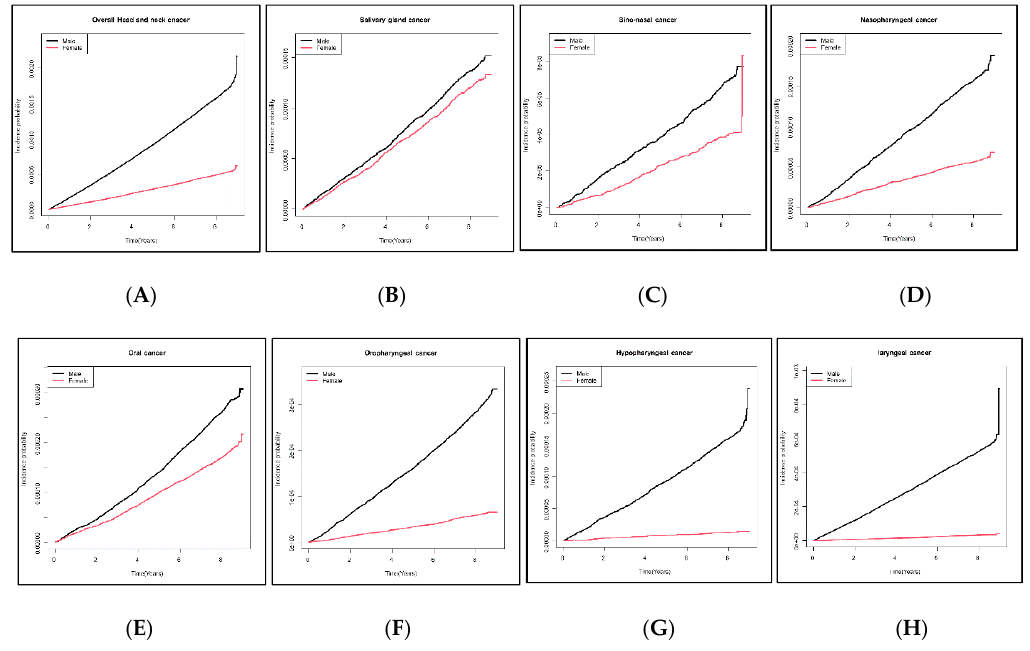
Figure 2. Kaplan–Meier curve of the cumulative incidence of various head and neck cancers in the original cohort of healthy males and females: ( A ) all head and neck cancers; ( B ) salivary gland cancer, ( C ) sinonasal cancer, ( D ) nasopharyngeal cancer, ( E ) oral cancer, ( F ) oropharyngeal cancer, ( G ) hypopharyngeal cancer, and ( H ) laryngeal cancer.